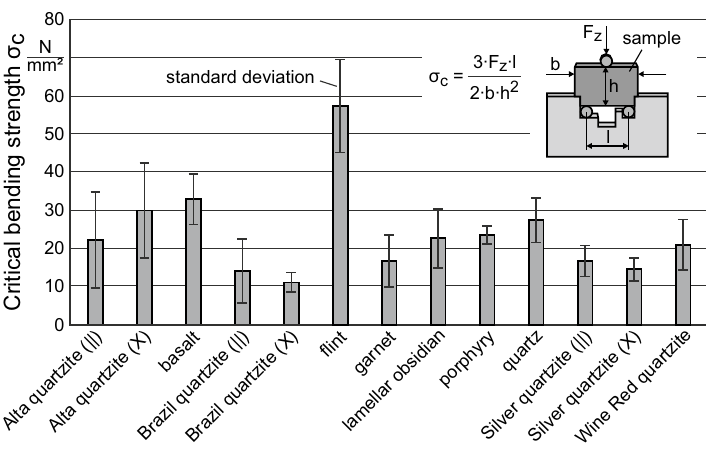
Fig. 7 Critical bending strength of the rocks deter- mined using three-point- bending-tests